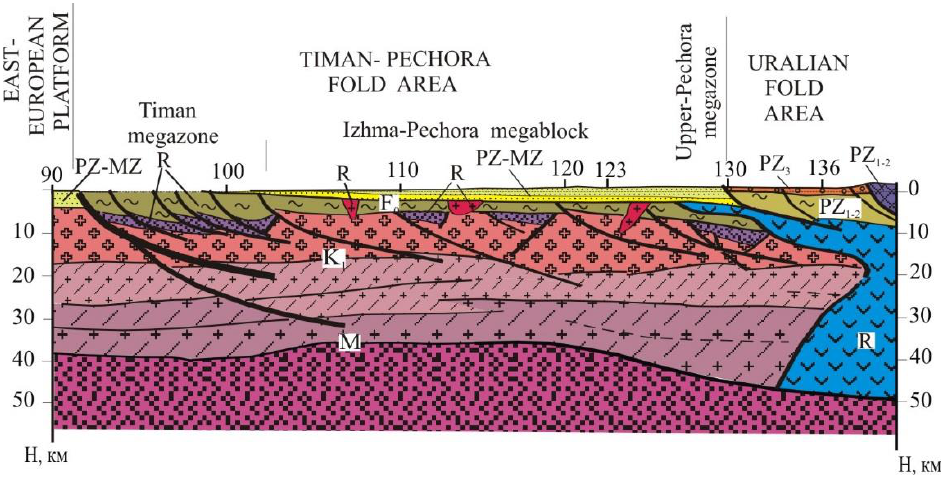
Figure 7. Section of the crust of the Timan-Pechora fold area (fragment of the “Murmansk-Kyzyl” geo-traverse). Compiled using materials from the Center «GEON» and VSEGEI. See Figure 2 for legend.